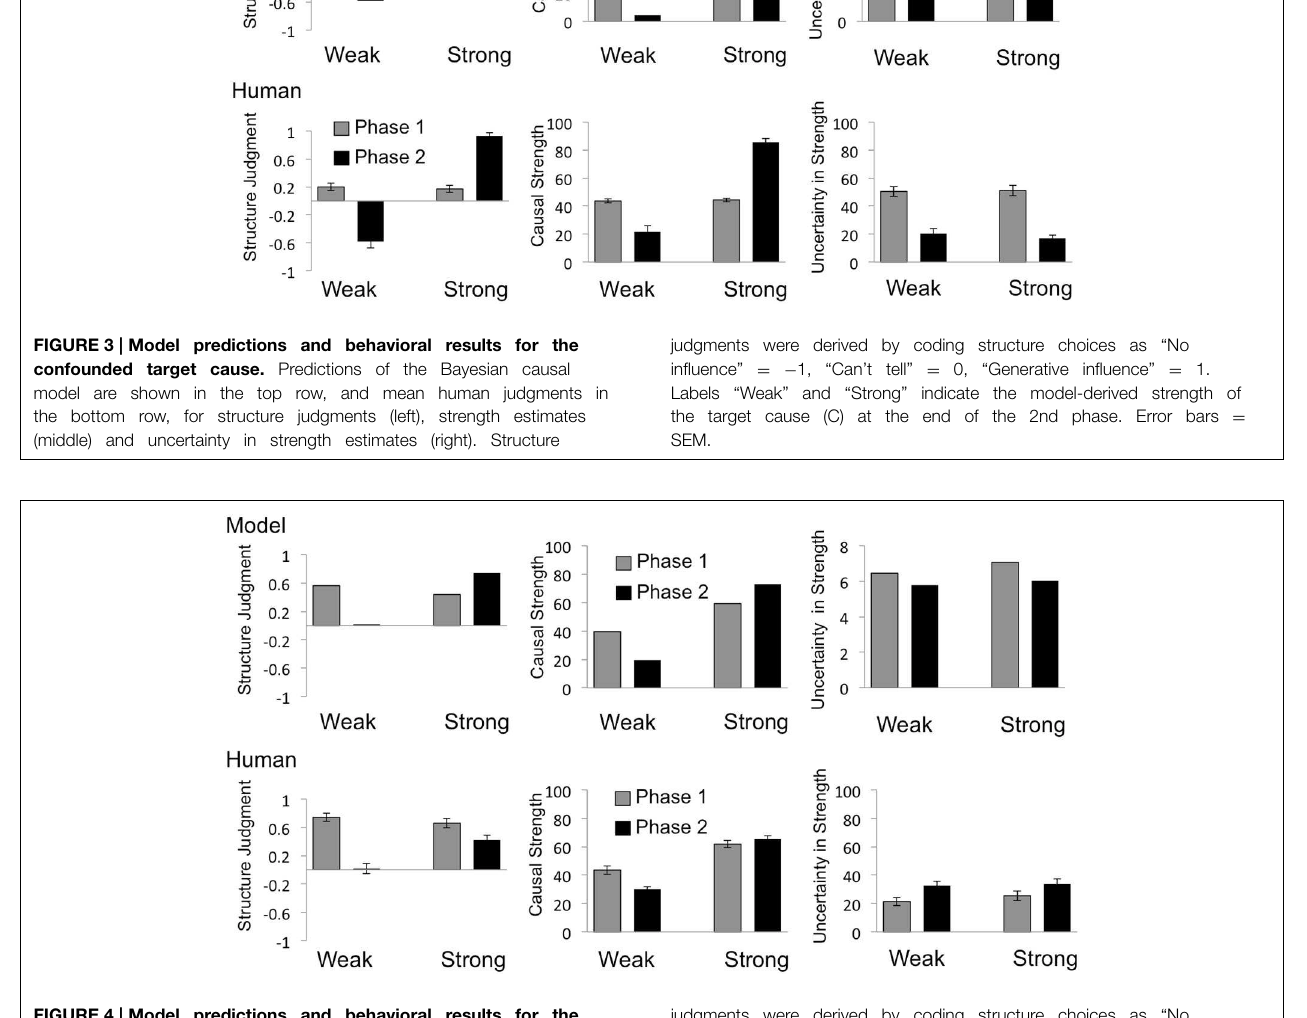
FIGURE 4 | Model predictions and behavioral results for the interacting target cause. Predictions of the Bayesian causal model are shown in the top row, and mean human judgments in the bottom row, for structure judgments (left), strength estimates (middle) and uncertainty in strength estimates (right).